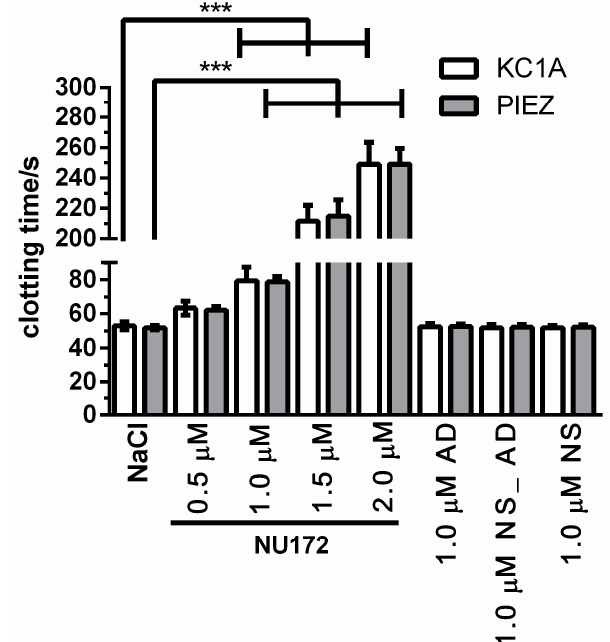
Figure 3. Detection of clotting time (CT) of citrated blood using PIEZ and ball coagulometer (KC 1A) after the addition of 0.5, 1.0, 1.5, or 2.0 µ M NU172. Additionally, the CT of blood samples containing NaCI, 1,0 µ M AD, NS_AD, or NS were measured. (n = 10 ± SD). The statistical analysis was performed using two-way ANOVA. (*** p < 0.001). The CTs measured by KC 1A and PIEZ were not significantly different.